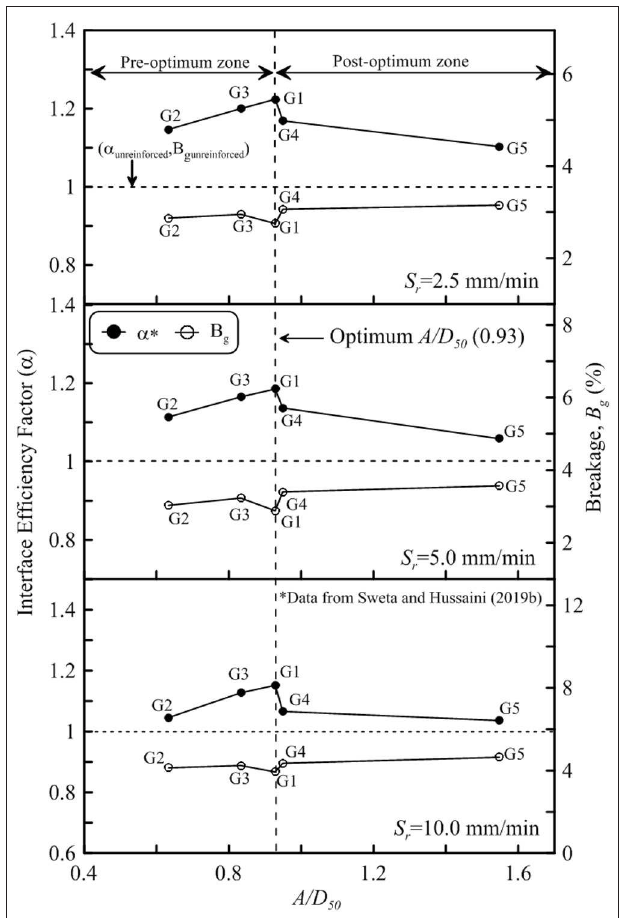
FIGURE 6 | Variation of interface efficiency factor ( α ) and breakage ( B g ) with A/D 50 .